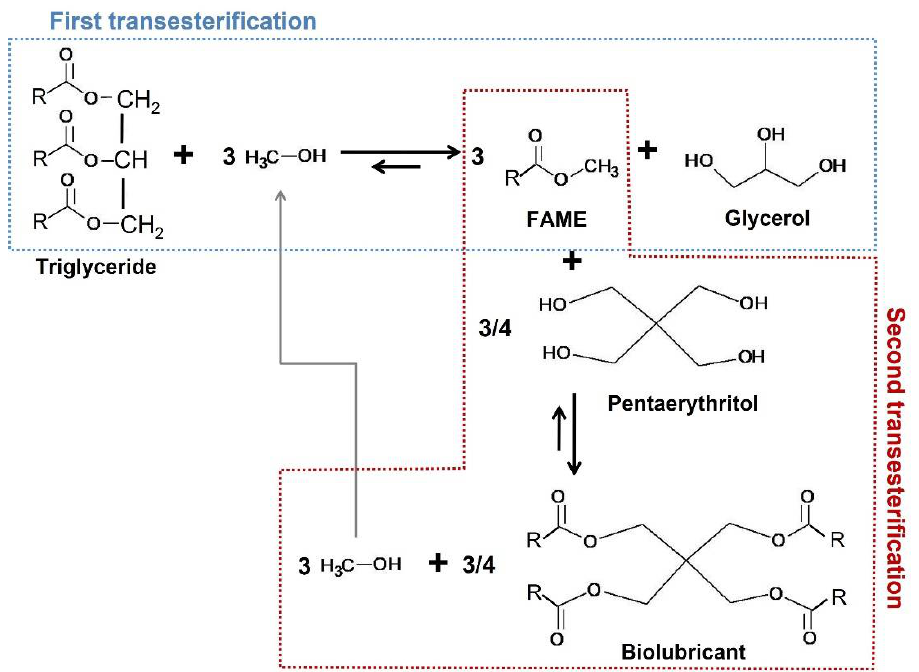
Figure 1. Biolubricant production through double transesterification.